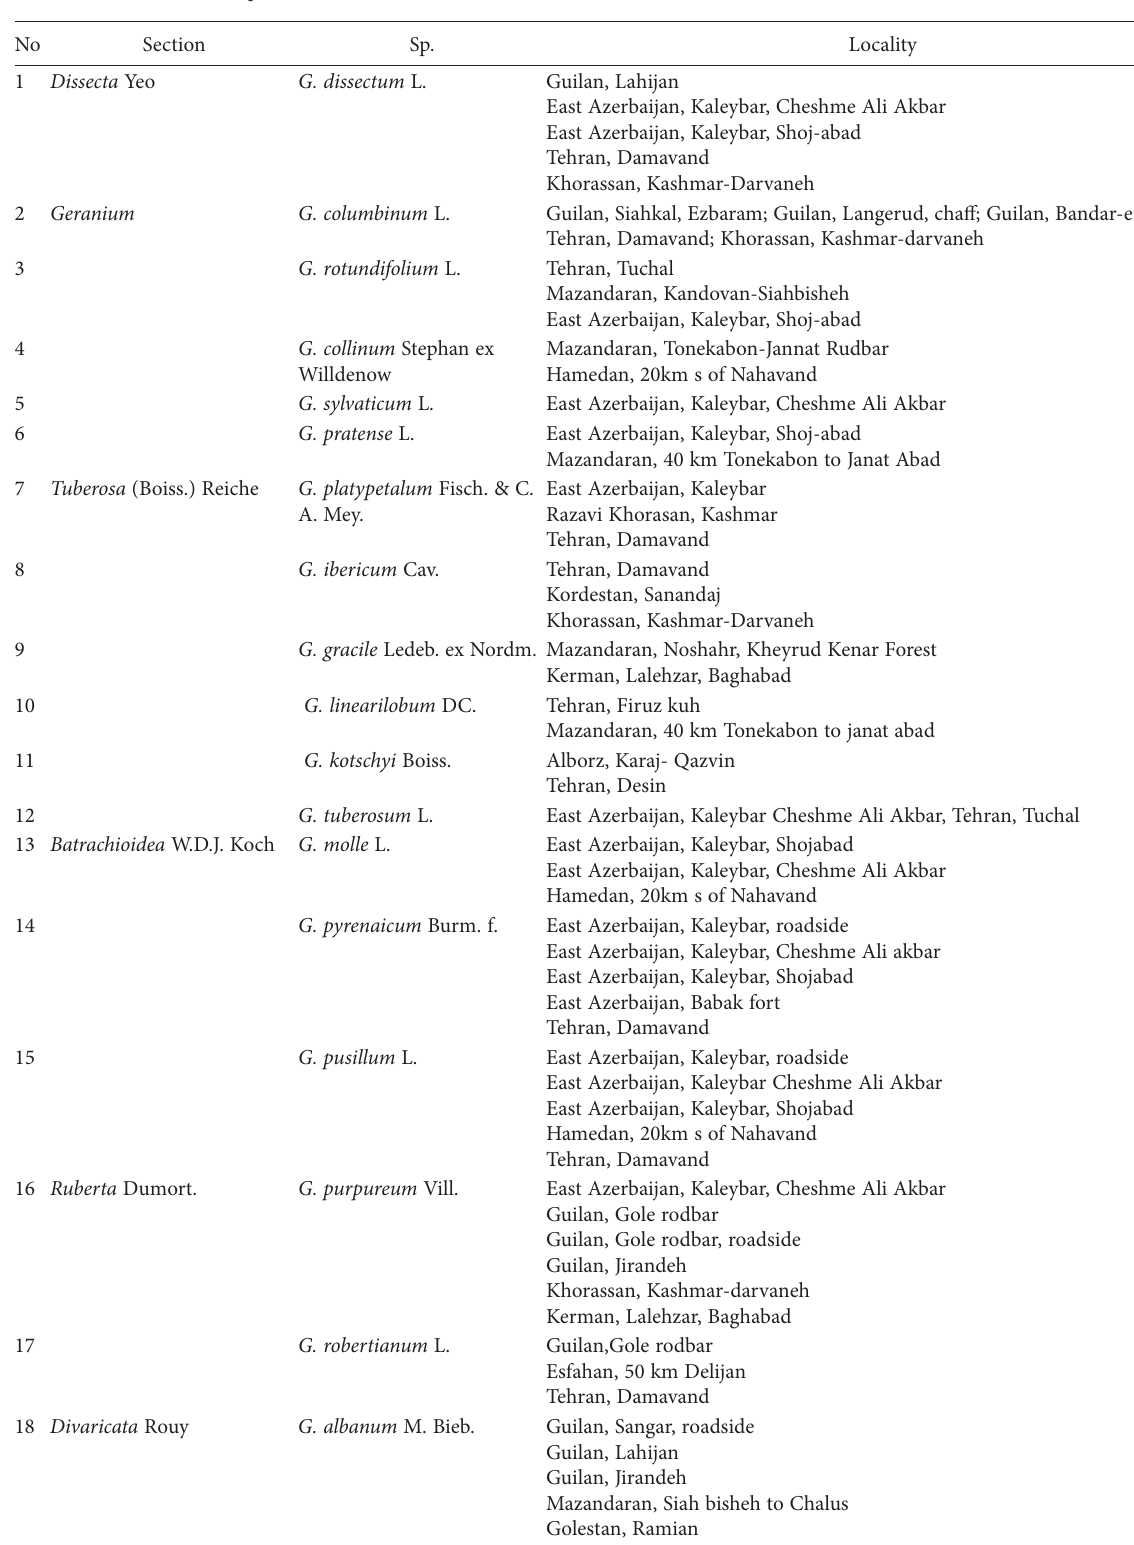
Table 1. List of Geranium species in Iran their localities and voucher numbers. No Section Sp.